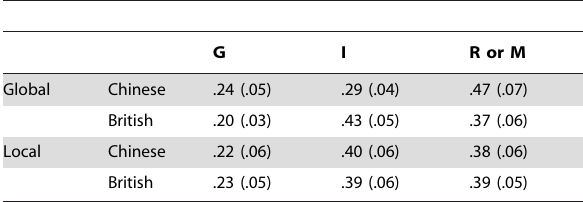
Table 3. Mean Proportions for Each Attribution of Each Group in the Classification Test for Target Regularity.